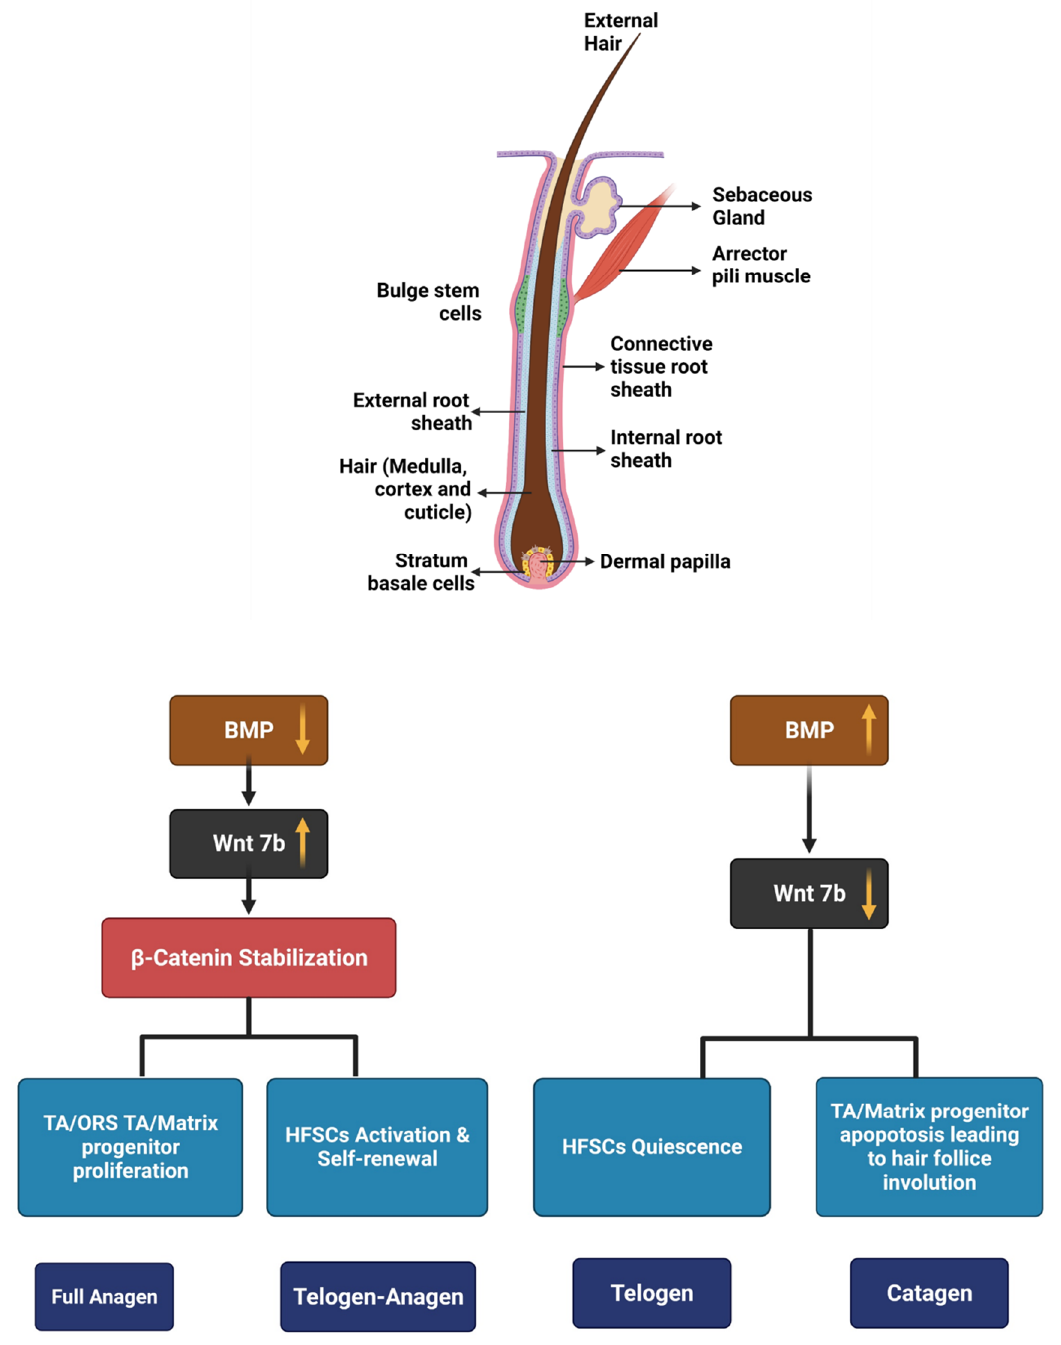
Figure 1. Structure of hair follicle and the molecular mechanisms involved in hair cycle. (BMP—bone morphogenetic protein, TA—transit amplifying, ORS—outer root sheath, HFSCs—hair follicular stem cells). Created with BioRender.com (accessed on 27 January 2022).